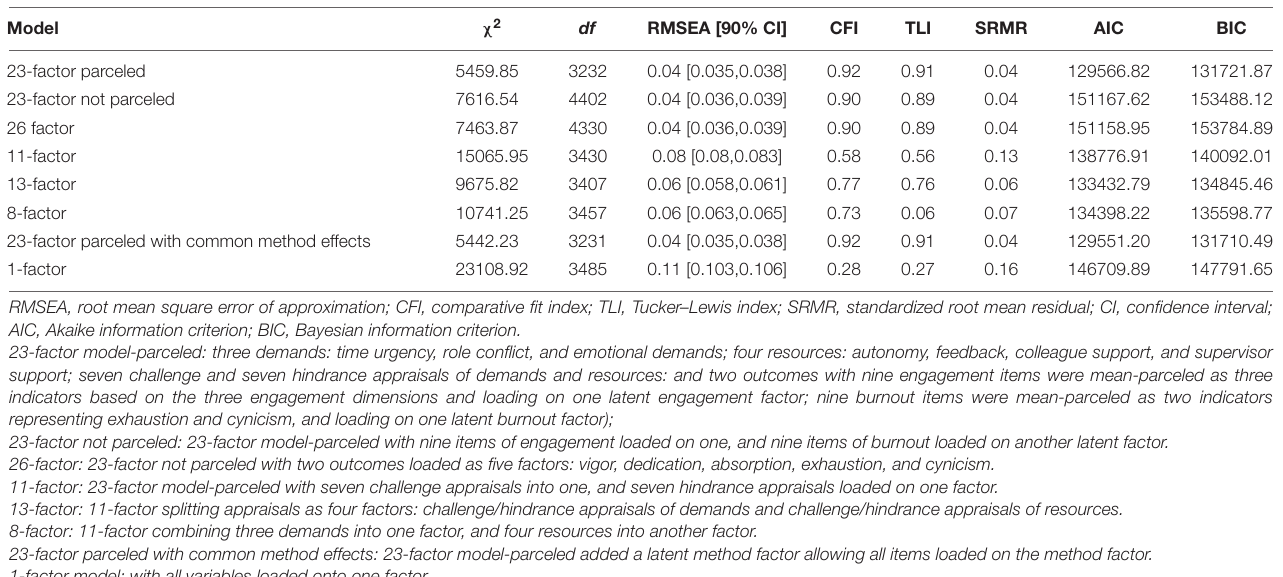
TABLE 1 | Results of confirmatory factor analyses in Study